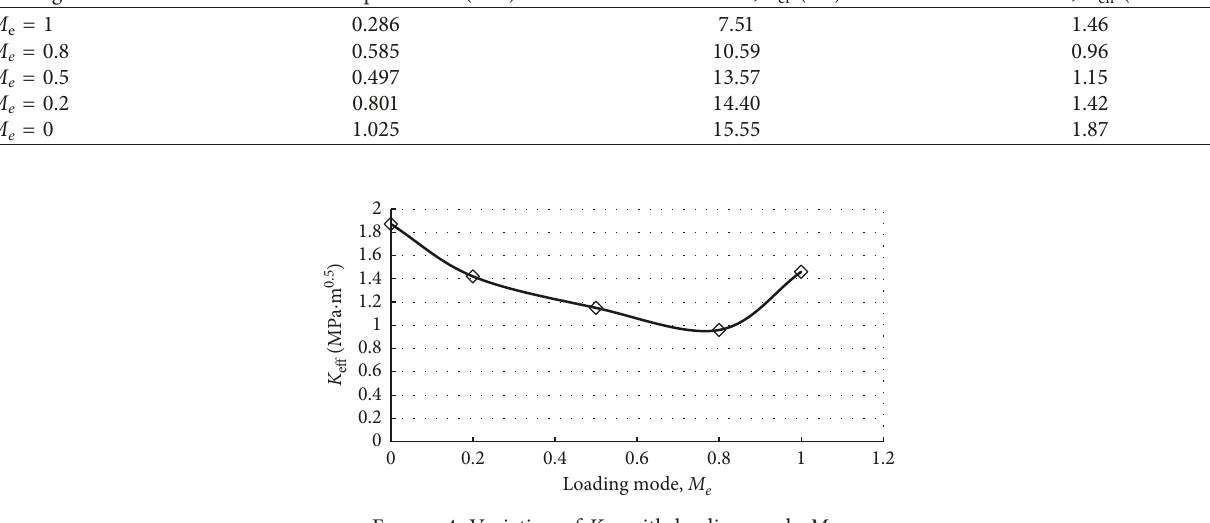
Figure 4: Variation of K eff with loading mode M e